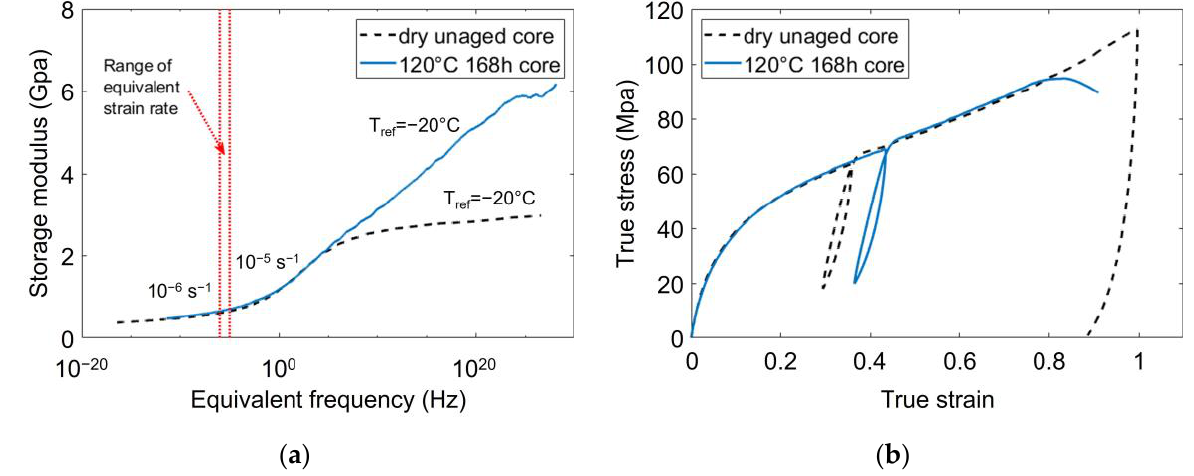
Figure 15. Superposition of two typical master curves. The dry unaged PA66 and the aged one are both loaded on their rubbery plateau. The corresponding strain-stress curves are plotted on the right.